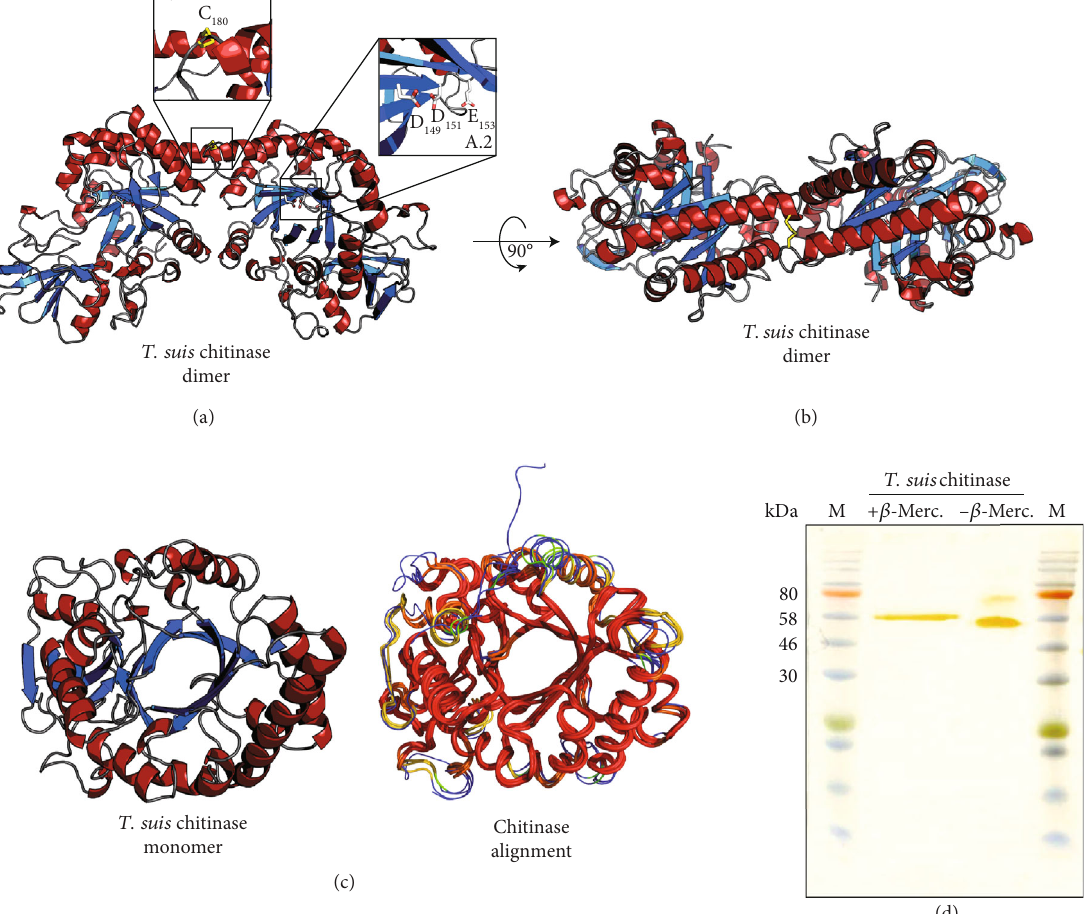
Figure 7: Three-dimensional structure of T. suis chitinase ( Ts- Chit). (a) Overall structure of Ts -Chit forming a C2-symmetric dimer ( α -helices in red, ß-strands in blue). The inset A.1 depicts the dimer-stabilizing disul fi de bond-forming cysteine residue at position 180, while the inset A.2 highlights the catalytic DxDxE center. (b) Ts -Chit dimer rotated by 90 ° compared to (a). (c) Ts -Chit monomer and its structural alignment with AMCase (PDB Id 3FXY, [84]), human Chit1 (PDB-Id 1GUV, [85]), human YKL-40 (PDB-Id 1NWR, [86]), and murine Ym1 (PDB-Id 1VF8, [87]). (d) Silver-stained SDS/PAGE gel of recombinantly expressed Ts -Chit (1 μ g) under reducing (+ß-Merc.) and nonreducing (-ß-Merc.) loading